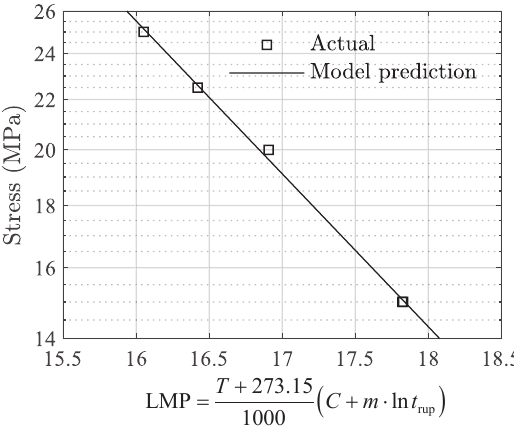
Figure 11. The actual and calculated results on stress vs.